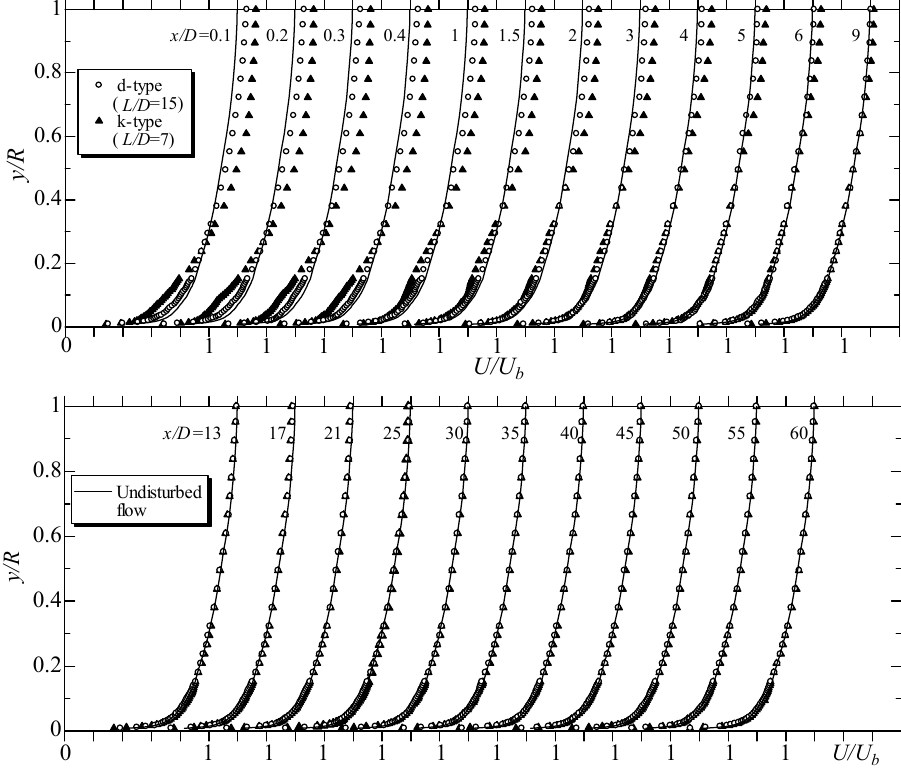
Fig. 6 Comparison of deformation and recovery process of the mean velocity profile under the same effective pressure drop